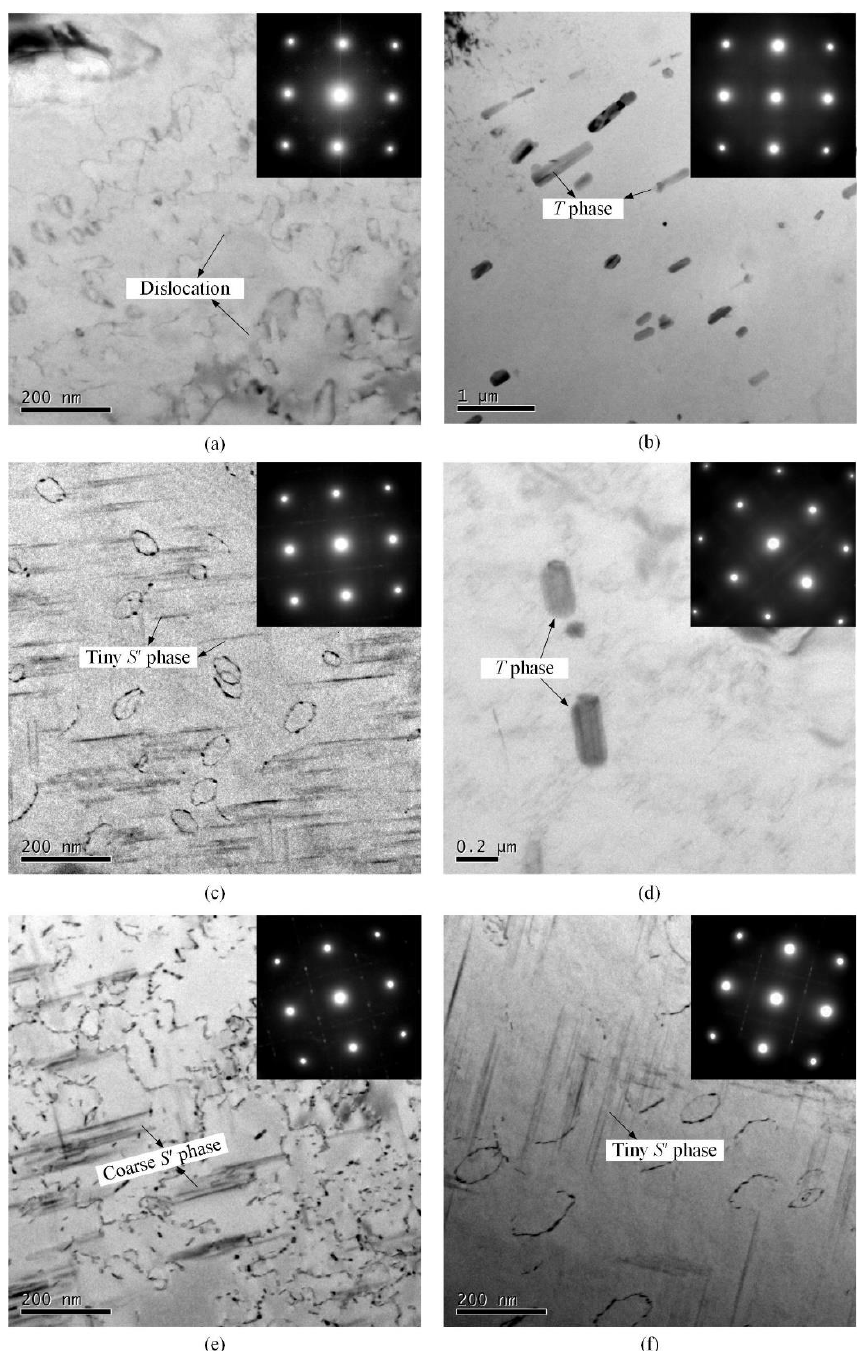
Figure 4. TEM bright field images and selected area electron diffraction (SAED) patterns along a <100> Al zone axis for AA2524 under different aging conditions: ( a ) creep aged (CAF)-4h; ( b ) stress-free aged (SFA)-4h; ( c ) CAF-9h; ( d ) SFA-9h; ( e ) CAF-24h; ( f ) SFA-24h.